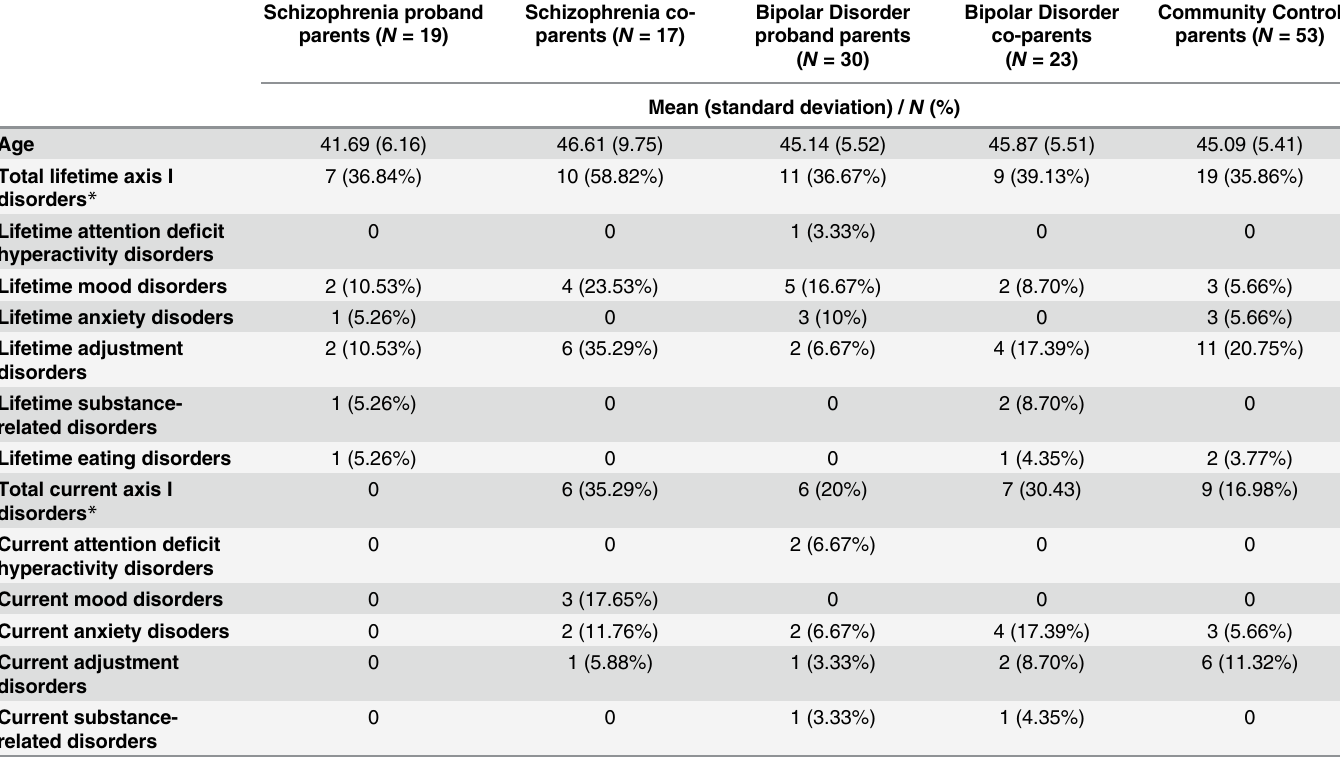
Table 1. Clinical characteristics of